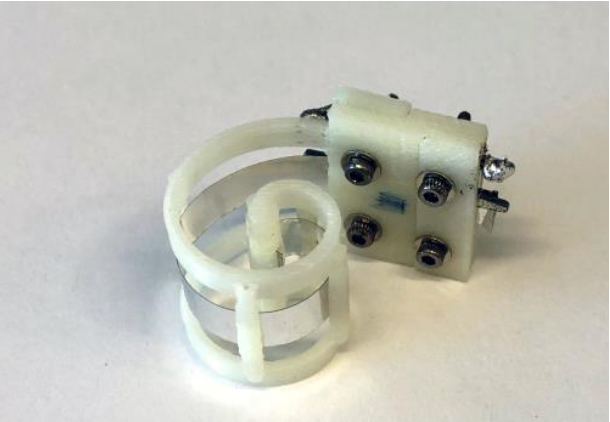
Figure 7. Fabricated spiral-shaped PVDF sensor clamped onto an ABS support. The magnitude (Figure 8a) evidenced a trend characteristic of a capacitive device, in accordance with the BVD model. The effect of the multiple resonance characteristics of the proposed geometry is more clearly visible on the phase, which is characterized by multiple local maxima (Figure 8b).